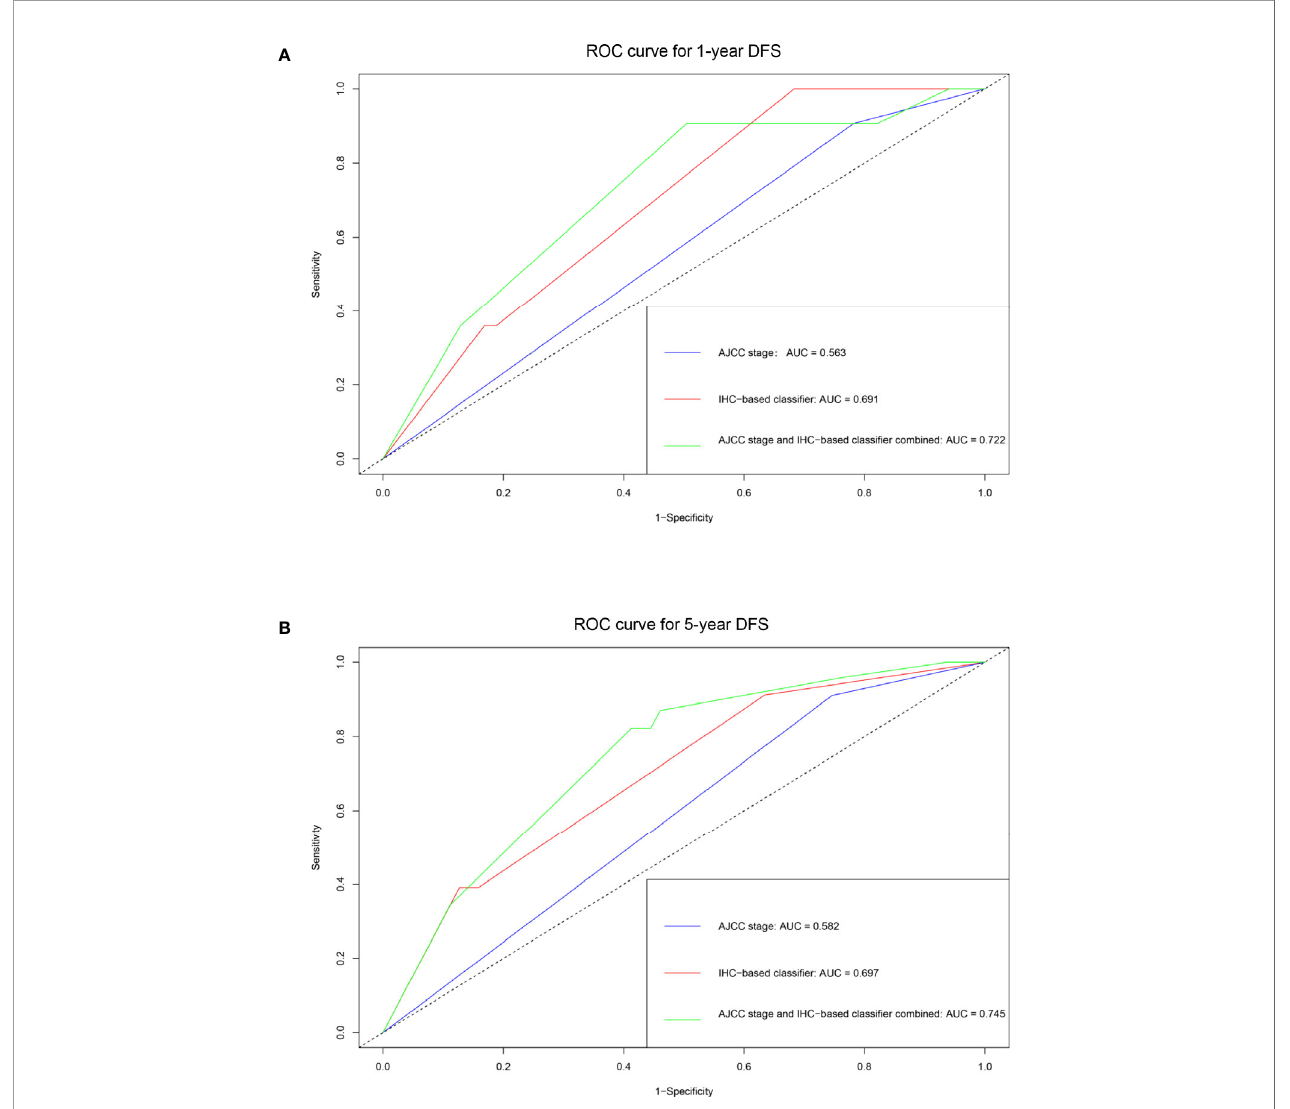
FIGURE 4 | ROC curve analyses of the prognostic value of IHC-based classi fi er and AJCC stage. (A) 1-year DFS. (B) 5-year DFS.